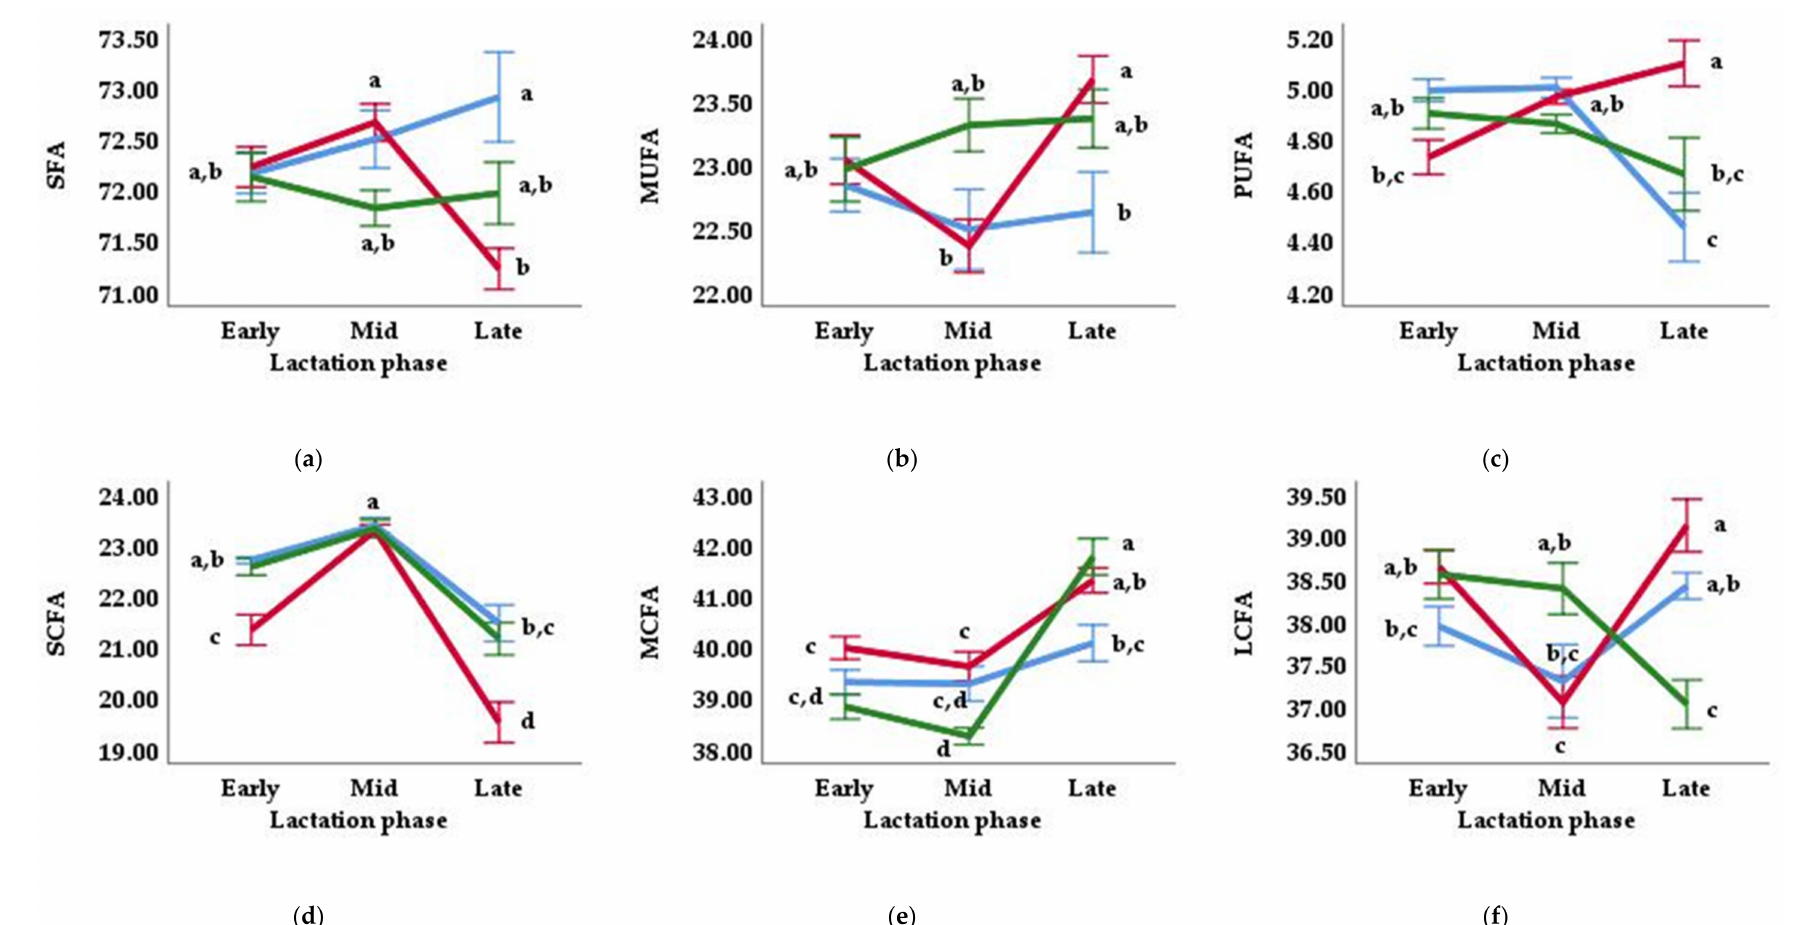
Figure 2. Interactive effect of the dietary treatment and the lactation phase (early, mid, late) on different types of fatty acids (FAs): saturated FAs, SFA ( a ); monounsaturated FAs, MUFA ( b ); polyunsaturated FAs, PUFA ( c ); short-chain FAs, SCFA ( d ); medium-chain FAs, MCFA ( e ) and long-chain FAs, LCFA ( f ). The three diets were the control (blue line), DOP40 (red line), and DOP80 (green line). Values presented are the means (g/100 g FA), with a,b,c,d indicating differences between mean values ( p ≤